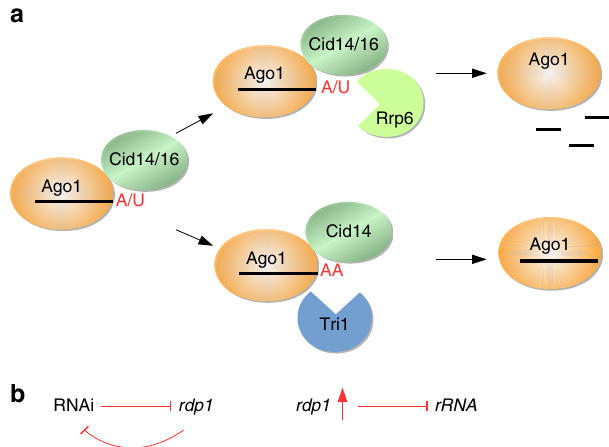
Figure 7 | Cid14/Cid16 and Rrp6 degrade Argonaute-bound sRNAs to protect the genome from uncontrolled RNAi. ( a ) Cid14 adenylates and Cid16 uridylates Argonaute-bound sRNAs in fission yeast. Both Cid14 and Cid16 recruit the Rrp6 nuclease to actively degrade sRNAs from Argonaute. Adenylation by Cid14 can recruit either Triman or Rrp6. Rrp6 will degrade Argonaute-bound sRNA. To the contrary, Triman will trim Argonaute-bound sRNAs to 22 nucleotides and make them functional again. ( b ) Degradation of Argonaute-bound sRNAs is necessary to reduce accumulation of ‘noise’ sRNAs in Argonaute and to protect the genome from uncontrolled RNAi. In cid14 D and cid14 D cid16 D cells RNAi targets the rdp1 gene and suppresses itself. Over-expression of Rdp1 in cid14 D cells silences rRNA and many euchromatic genes and strongly impairs the growth. This indicates that the re-programing of rdp1 expression is essential for viability of cid14 D and cid14 D cid16 D